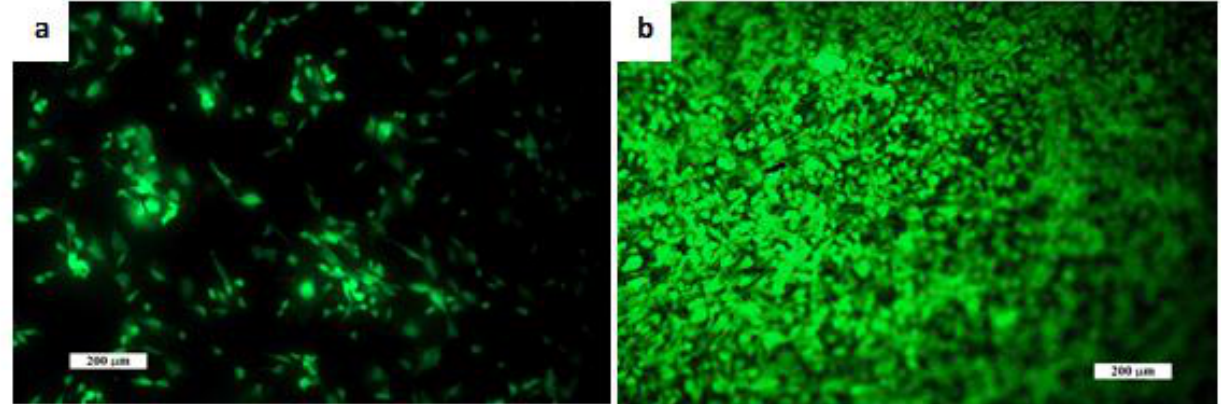
Figure 4. Distribution and morphology of an osteoblast cultured on ceramic samples for ( a ) 2 days and ( b ) 9 days (live/dead staining). The growth of the cell population is clearly visible and ( b ) a dense layer of osteoblasts covers the entire ceramic surface. Cell adhesion and proliferation was very good, and no dead cells were observed. Scale bar: 200µm.